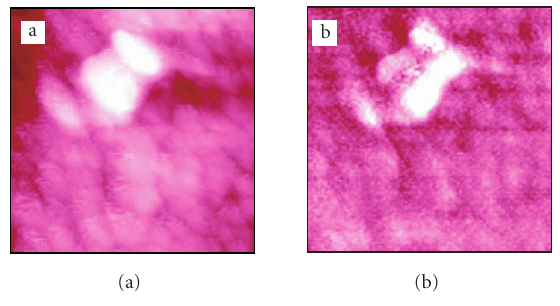
Figure 14: Structure detail of a fossil bacterium in a polished dolomite sample: (a) shear-force AFM (5 μ m, Z range 300nm); (b) simultaneous SNOM image indicating the chemical di ff erence at the bright contrast